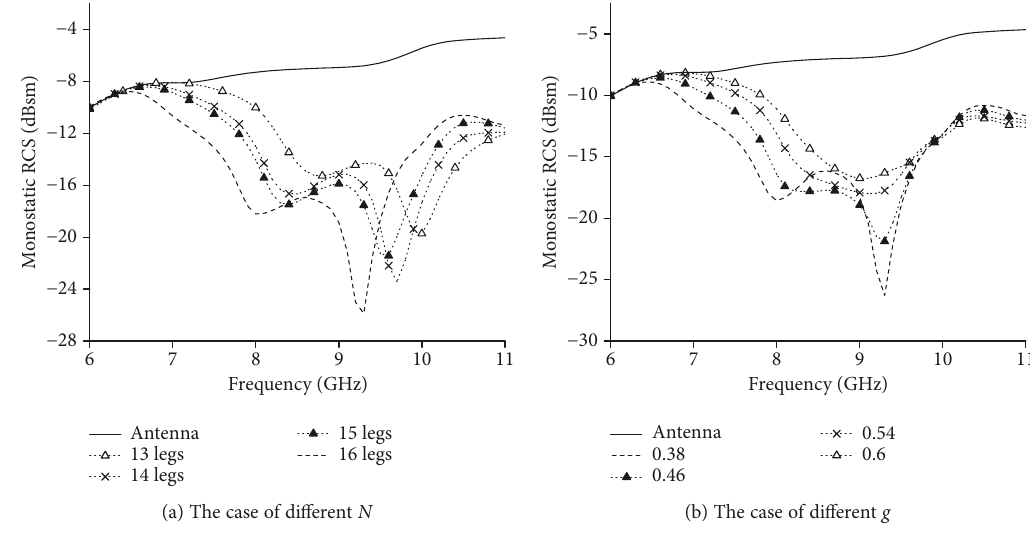
Figure 3: The monostatic RCS of the antenna for the case of di ff erent parameters